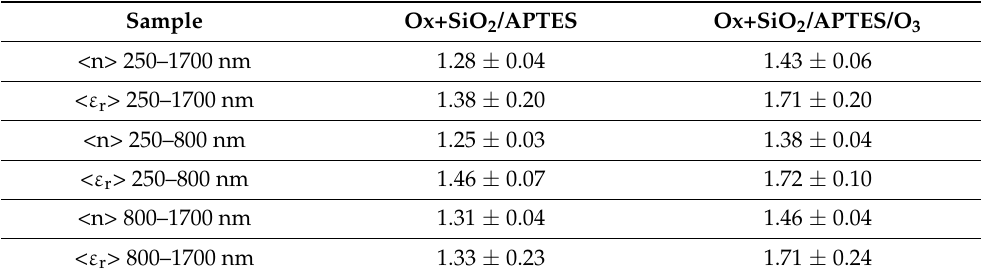
Table 3. Average values of the refraction index, <n>, and the real part of dielectric constant, < ε r >, for different wavelength